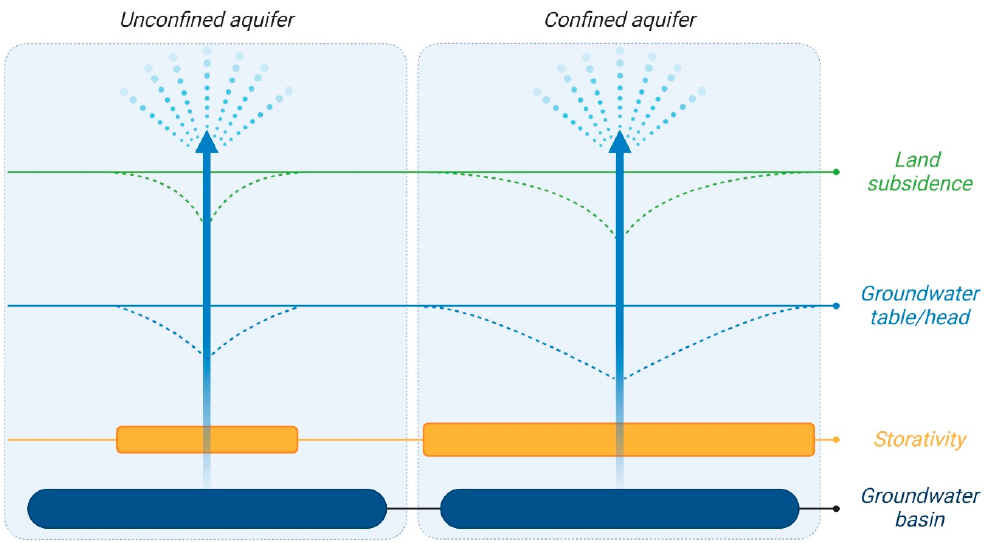
Figure 5. Groundwater system response to discharge and recharge in terms of changes in aquifer storativity, groundwater head and groundwater system compaction resulting in land subsidence for unconfined and confined aquifers.